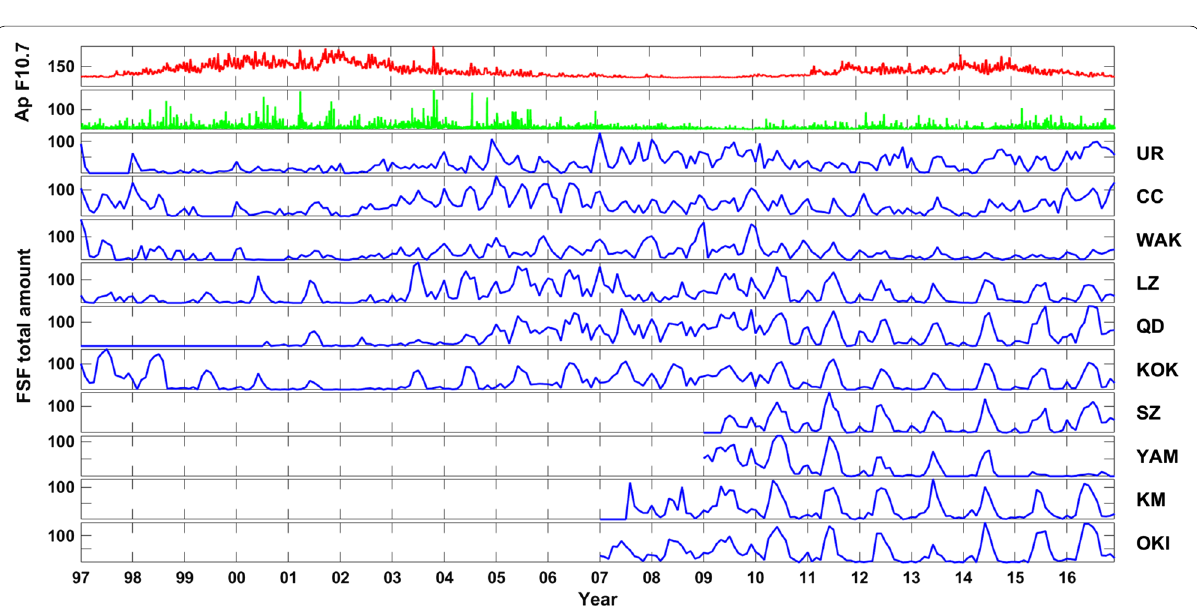
Fig. 3 Variations in daily F10.7, Ap index and FSF total amount at the 10 stations; the x -axis is the year and the y -axis is the FSF total